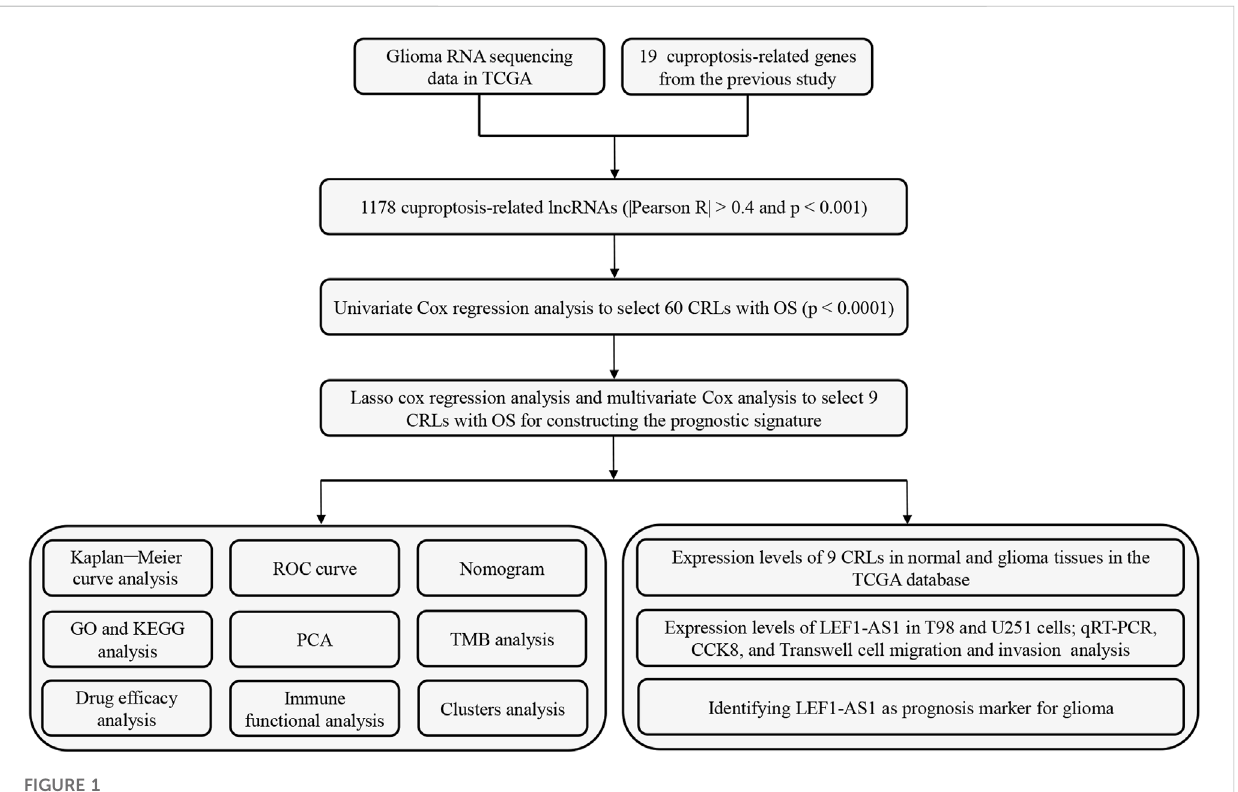
FIGURE 1 Flow diagram of the study